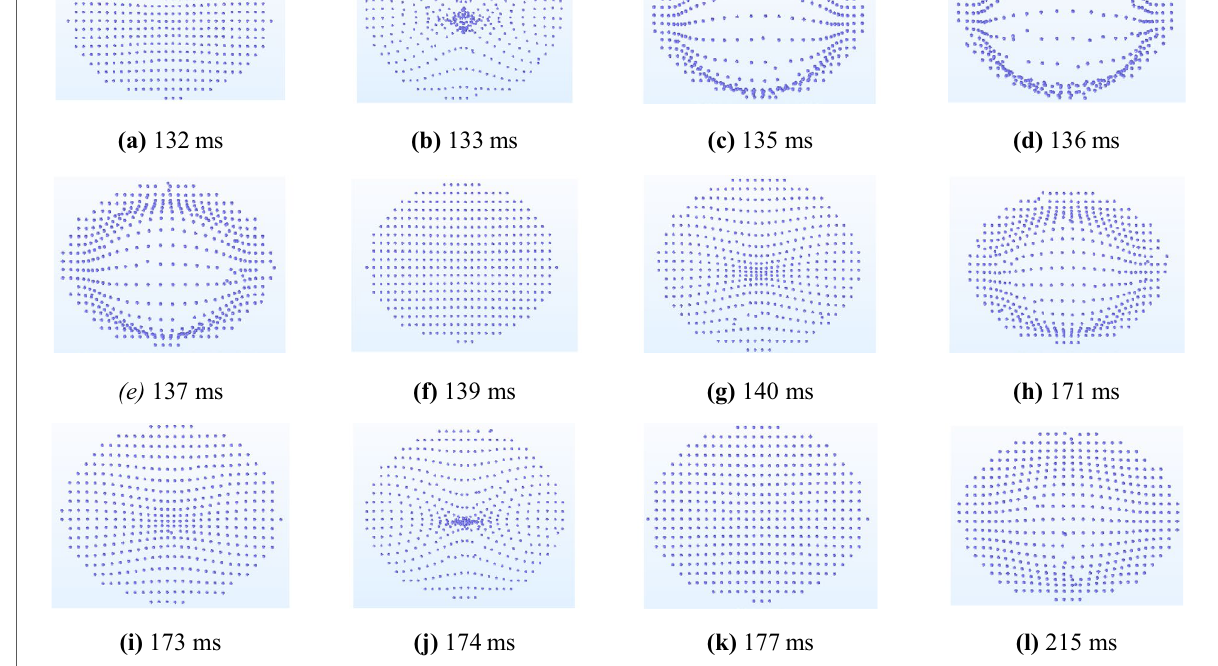
Figure 12 Dot matrix image of (0, 2) mode laser